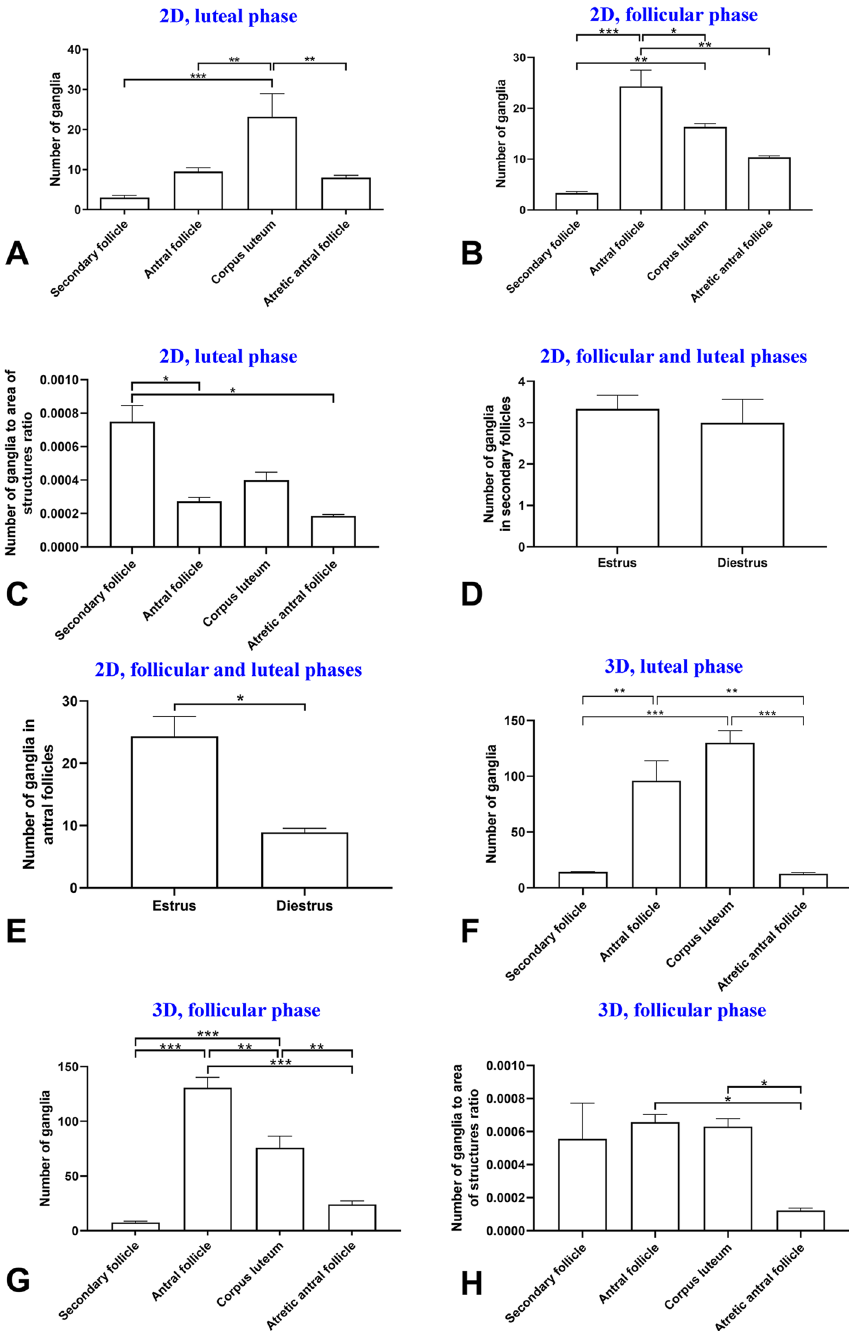
Figure 3. Comparisons of means and standard errors of variables in the three-dimensional (3D) and two- dimensional (2D) studies show the relationship of follicular growth and increase in ganglia number in the mouse ovary. Number of ganglia in luteal phase ( A ) and follicular phase ( B ) phases in follicles and corpora lutea in the 2D study. ( C ) Number of ganglia to area of structures ratio in luteal phase in the 2D study. ( D ) Number of ganglia in secondary follicles in follicular and luteal phase ovary in the 2D study. ( E ) Number of ganglia in antral follicles in follicular and luteal phase ovaries in the 2D study. ( F ) Number of ganglia in follicles and corpus luteum in the 3D study. ( G ) Number of ganglia to area of structures ratio in the 3D study (* p < 0.05, ** p < 0.01, *** p <